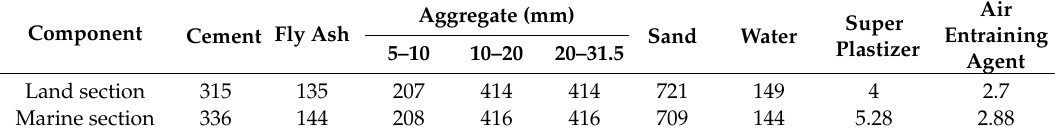
Table 2. Mix proportions of concrete used in the land and marine sections (kg/m 3 ).